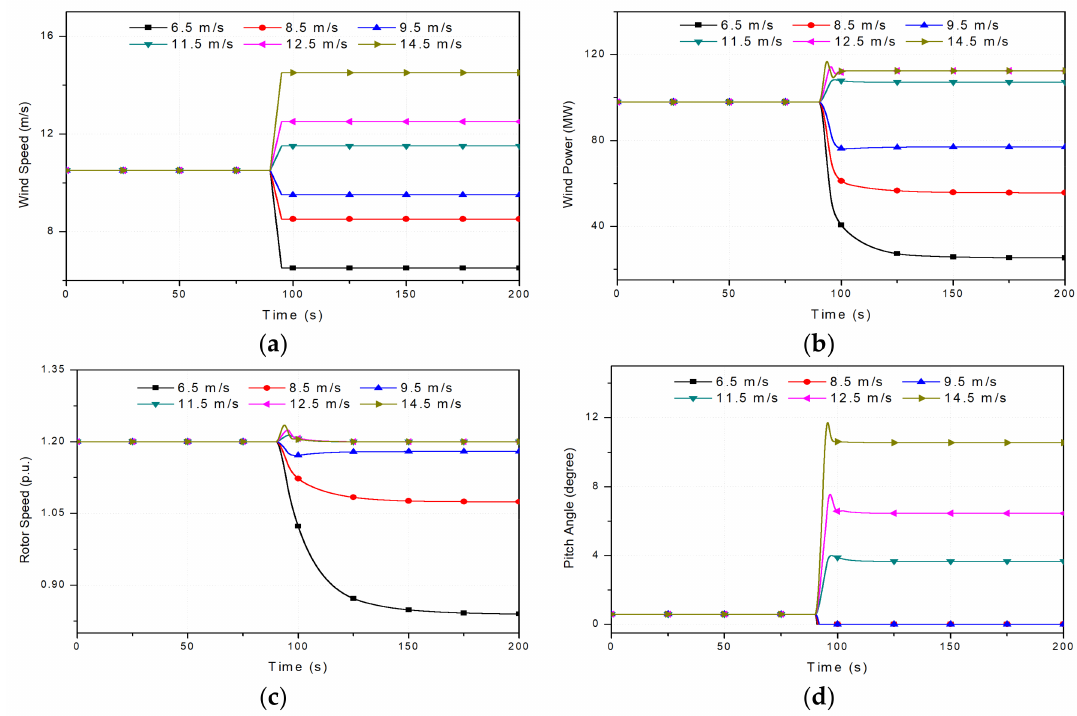
Figure 15. Simulation result with various wind speeds: ( a ) Wind speed; ( b ) Output power; ( c ) Rotor speed; ( d ) Pitch angle.